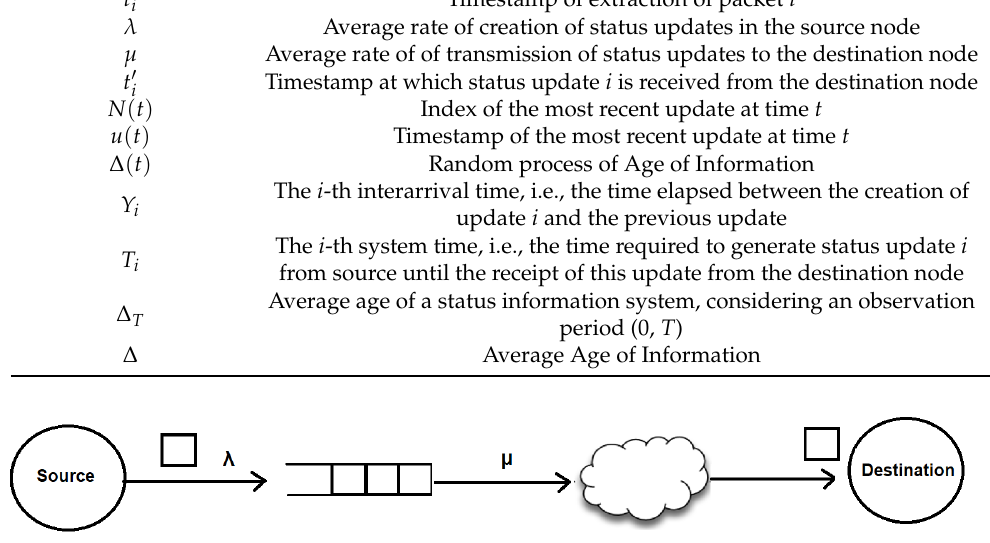
Figure 1. The basic model for Age of